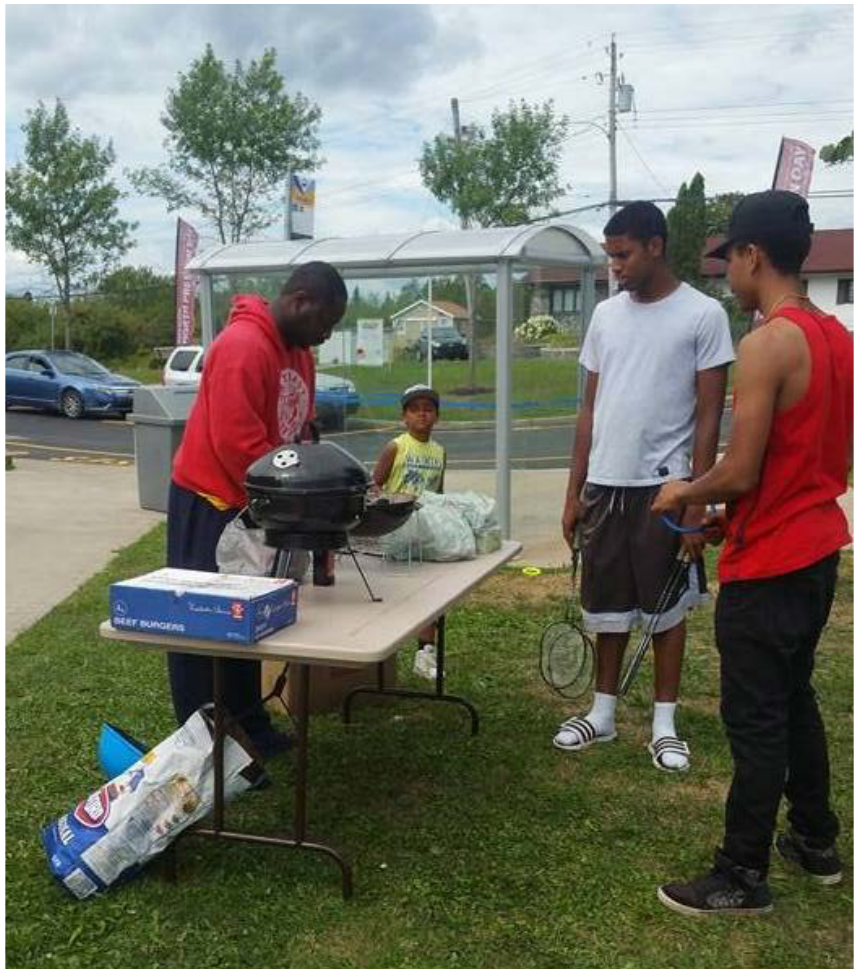
Figure 7. Community pop-up barbeque. Photo from Preston Facebook Page.